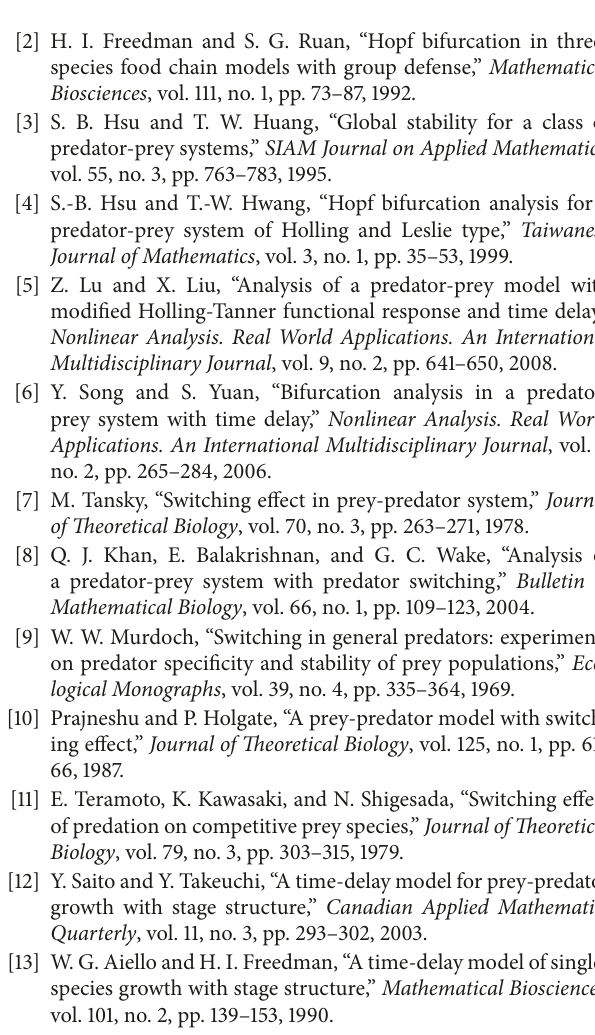
Figure 9: The behavior of 𝑥 1 , 𝑥 2 , and 𝑦 with respect to 𝑡 for equilibrium 𝐸 3 2 with 𝜏 = 2.6 .